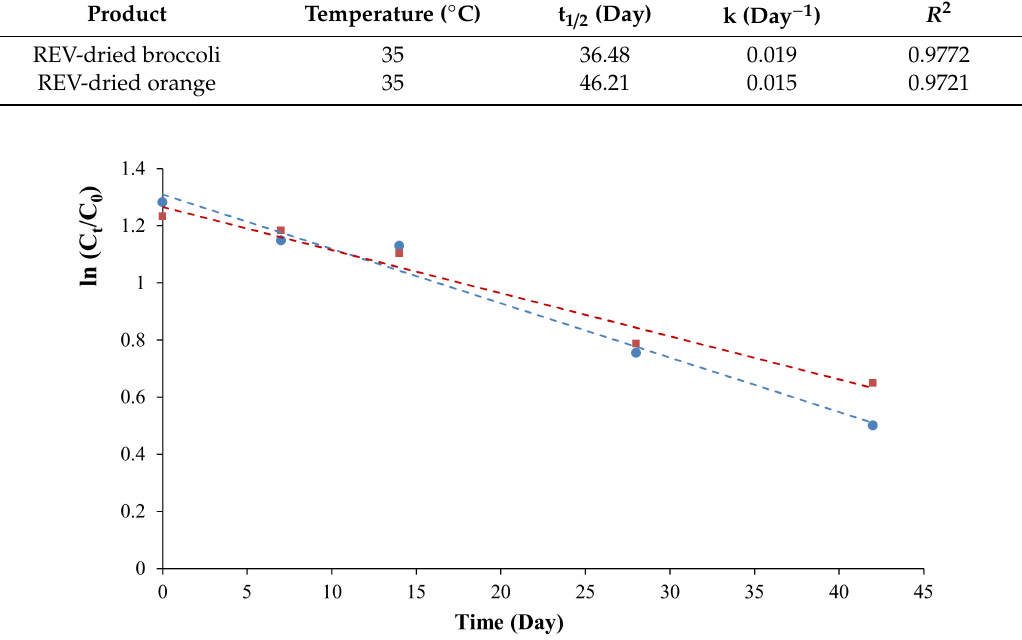
Figure 7. Linearized plot of ln(C t / C o ) vs time (Day), for REV-Dried broccoli ( • ) and orange ( (cid:4)